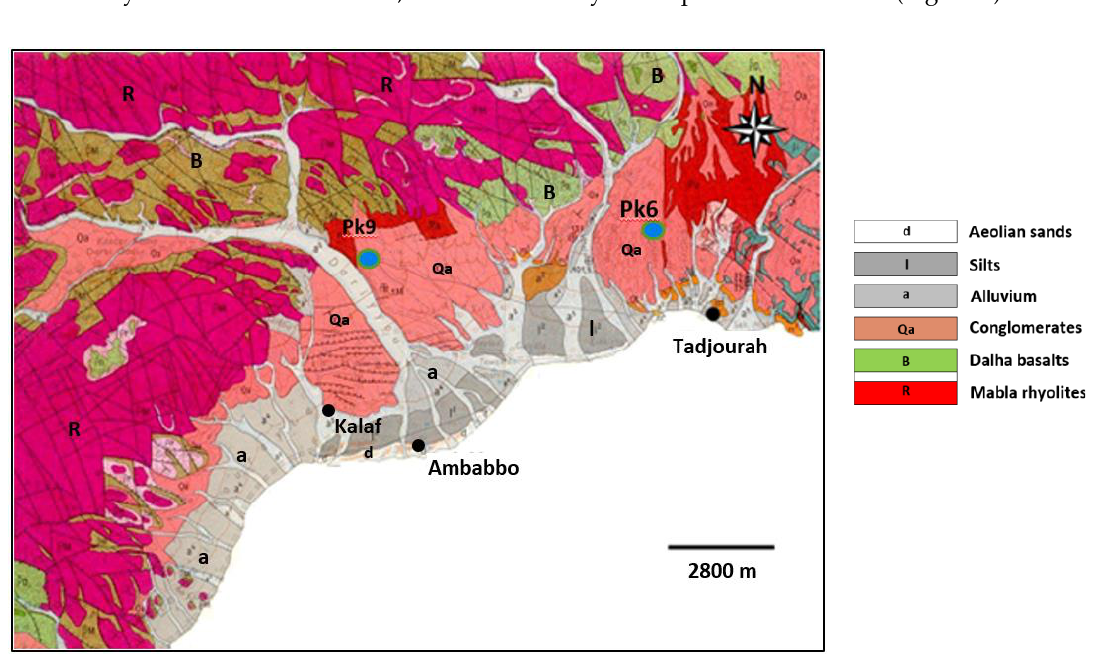
Figure 2. Geology of the coastal alluvial aquifer of Tadjourah. (Extracted from the geological map of the RoD at 1/100000. Tadjourah sheet [19]. d: Aeolian sands; a: alluvium; l: silt; Qa: Rhyolitic & basaltic conglomerates. Pliocene-Middle Pleistocene; R: Mabla rhyolites; B: Dalha basalts).